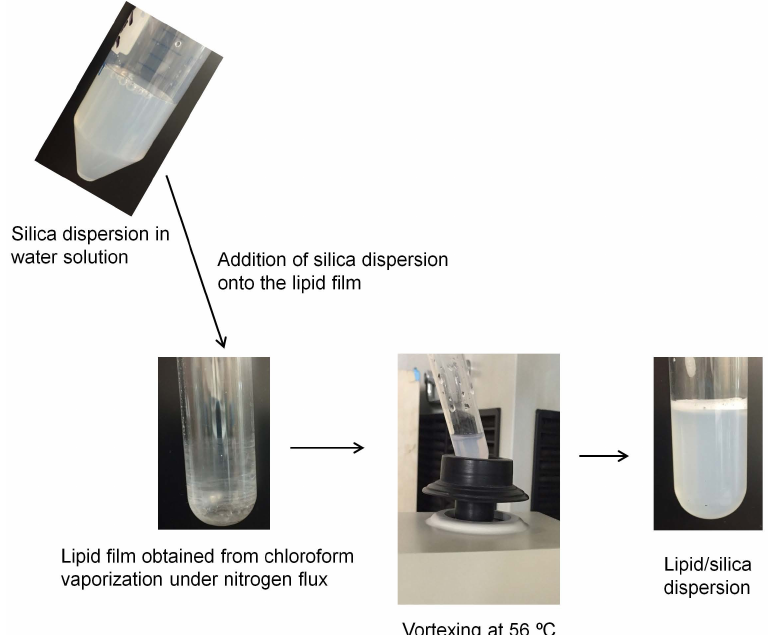
Figure 2. Procedure for dispersing silica/cationic lipid from lipid films. The lipid employed was either DOTAP or DODAB. Vortexing was done at an arbitrary temperature of 56 ◦ C, above the mean phase transition temperature of the DODAB or DOTAP